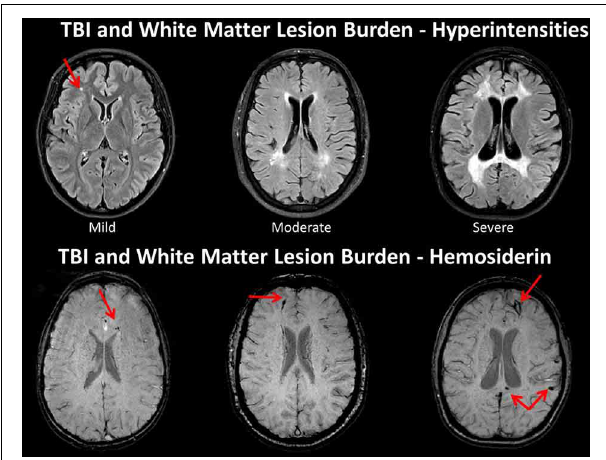
FIGURE 7 | TOP: Fluid attenuated inversion recovery (FLAIR) sequence in three traumatic brain injury (TBI) cases depicting different levels of white matter burden. (Left) a child with mild TBI (mTBI) indicating a solitary, focal white matter hyperintensity (WMH). (Middle) a 62-year-old male with a severe TBI with no white matter abnormalities noted on admission CT. Patient had a GCS of 7 prior to intubation, meeting criteria for severe TBI (Right) 17-year-old injured 2 years prior with an admission GCS of 3. Note the prominent and extensive WMHs widely distributed. BOTTOM : The middle and right hand subjects are the same as above, but subject on the left side is a different child with a mild TBI, who did not have a WMH, but did show hemosiderin in the corpus callosum (arrow). Note that both patients with severe injury have some generalized atrophy and ventricular dilation as a reflection of generalized brain volume loss as a consequence of severe TBI along with multiple hemosiderin